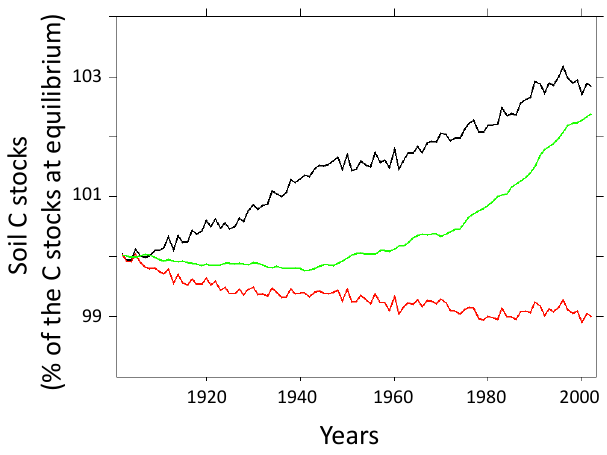
Fig. 2. C stock evolution over the 20th century normalized by the C stock at equilibrium (annual values) for ORCHIDEE-AR5 (black), ORCHIDEE-AR5-PRIM (red) and for O-CN (green). At equilib- rium, soil C stocks corresponded to 13.9kgm − 2 , 16.1kgm − 2 and 5.1kgm − 2 for ORCHIDEE-AR5, ORCHIDEE-AR5-PRIM and for O-CN,